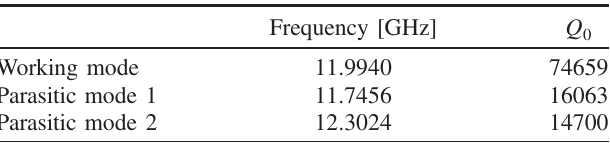
TABLE I. Modes of the correction